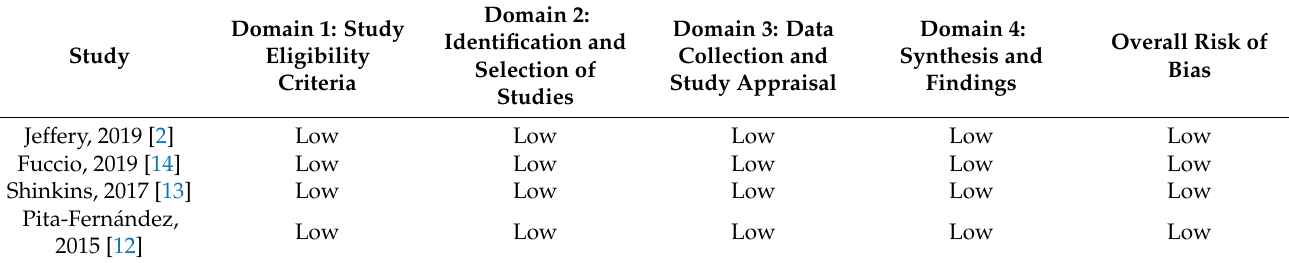
Table A3. ROBIS, systematic review/meta-analysis.